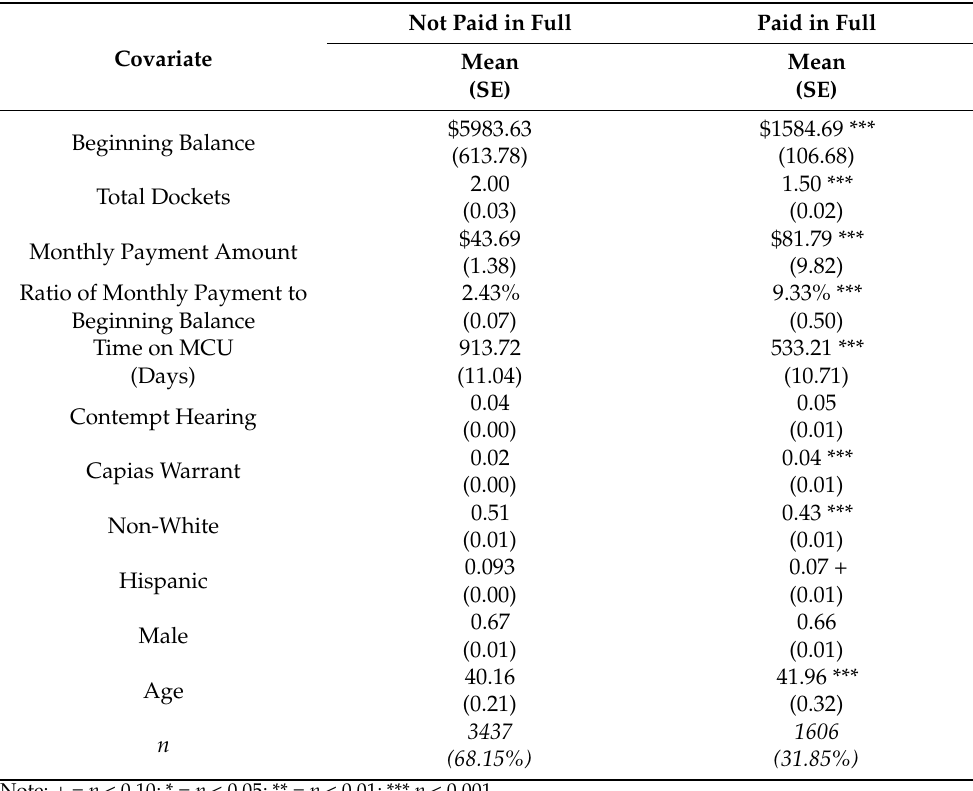
Table 2. Differences in Means between Persons Who Have and Have Not Fully Repaid Starting LFO